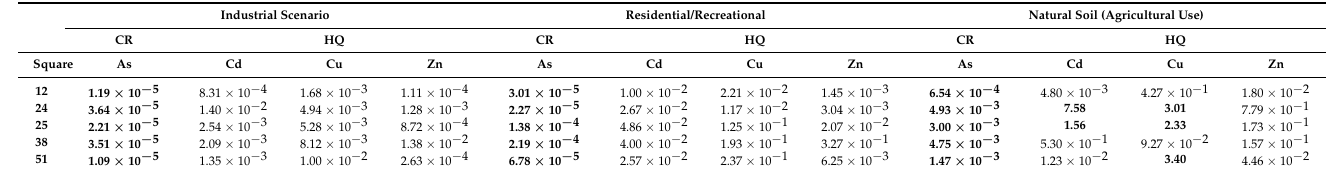
Table 5. Critical values of the risk characterization for carcinogenic (CR) and noncarcinogenic compounds (HQ) for various land uses. In bold: values exceeding risk limit for carcinogenic substances (Risk =10 − 5 and noncarcinogenic substances hazard quotient (HQ = 1). IndustrialScenario